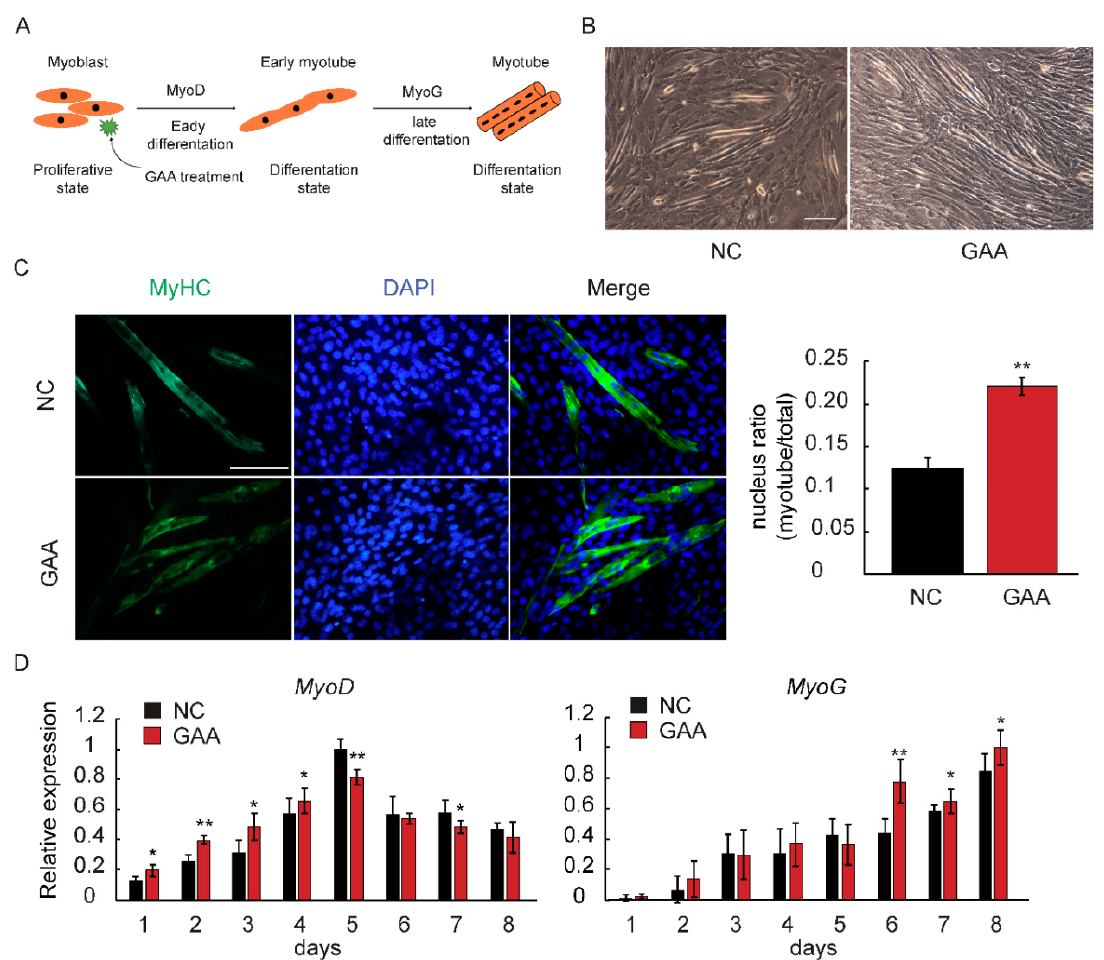
Figure 2. Effect of GAA on myoblasts during differentiation. ( A ) An overview of the experimental procedures; ( B , C ) myoblasts were induced to differentiate in the presence or absence of 20 mM GAA for 6 days. Images were obtained by brightfield microscopy on the 6th day of myoblast differentiation after 20 mM GAA treatment. Meanwhile, cells were stained with anti-MyHC antibody and the fusion index was calculated (Student’s t -test); negative control (NC) means a cell undergoes normal differentiation process; ( D ) the relative expression of marker genes of skeletal muscle differentiation (early phase: MyoD , later phase: MyoG ) was examined by quantitative real-time PCR (Student’s t -test). The results are expressed as the mean ± S.D. of three independent experiments. * p < 0.05; ** p < 0.01 compared with the negative control on the bars).